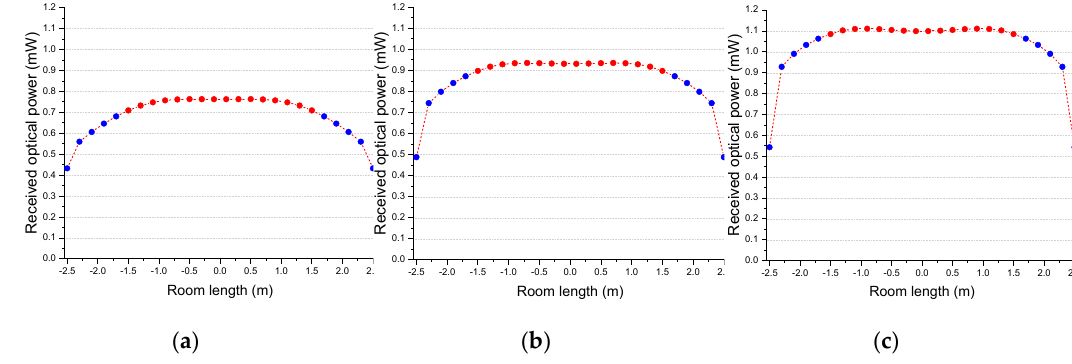
Figure 8. Mean received optical power with different reflection rates by ( a ) 0.2, ( b ) 0.5, and ( c ) 0.8.